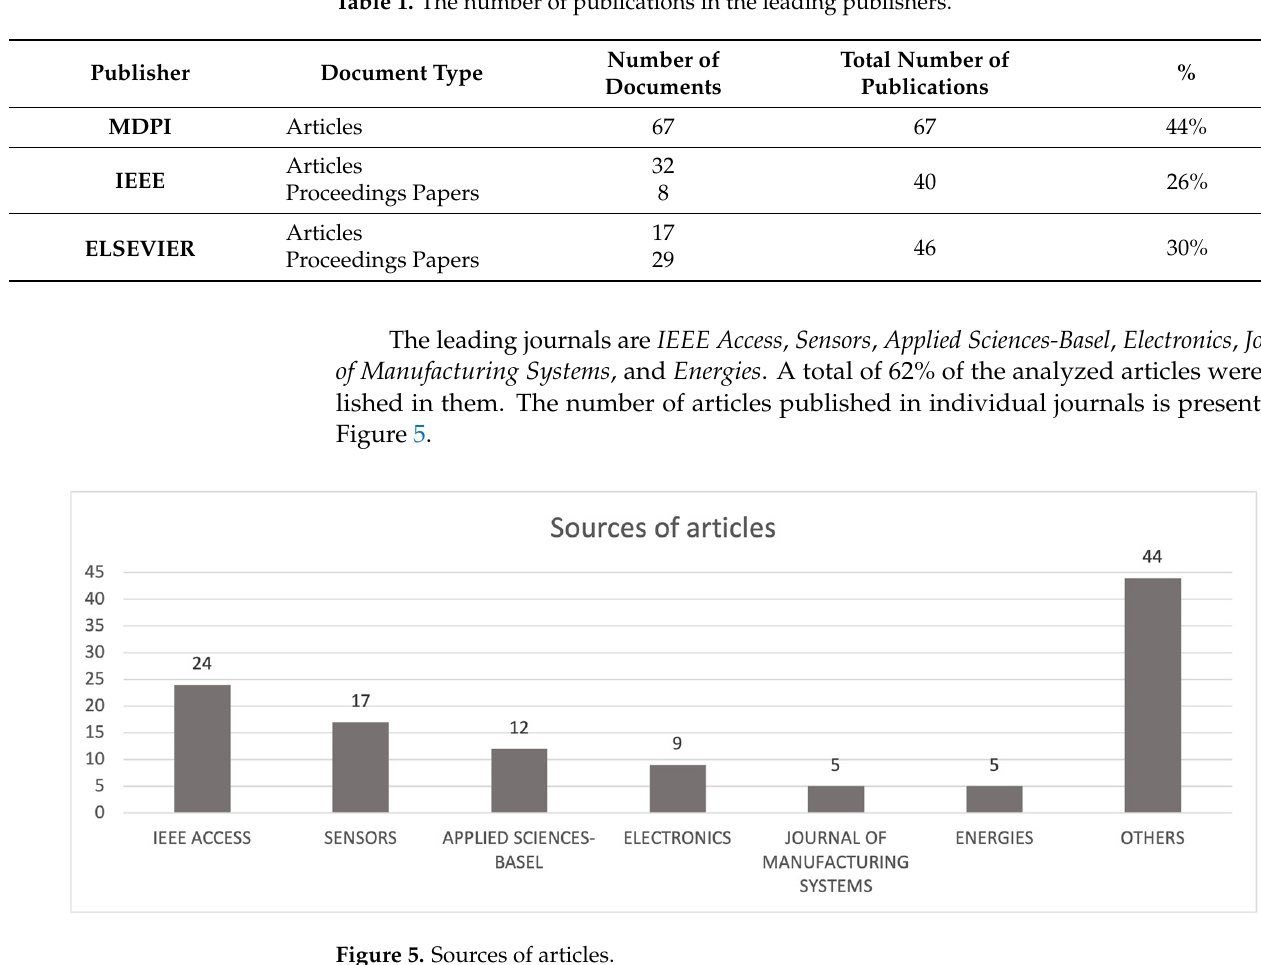
Table 1. The number of publications in the leading publishers.